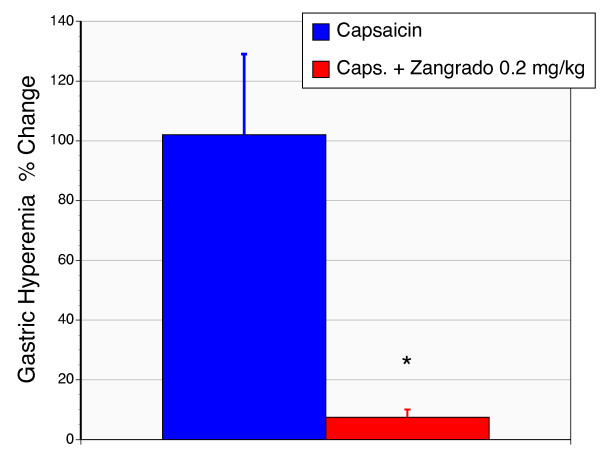
Effect of Zangrado on capsaicin-induced gastric hyperemia in rats. Capsaicin (320 μM) applied to the luminal surface of intact gastric mucosa results in a hyperemia as measured by laser Doppler flow. Rats pretreated with luminal Zangrado (0.2 mg/kg) ablated this hyperemia response (n = 5, P < 0.01).